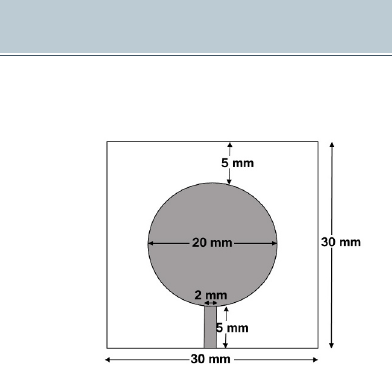
Figure 1. Top view of square geometry